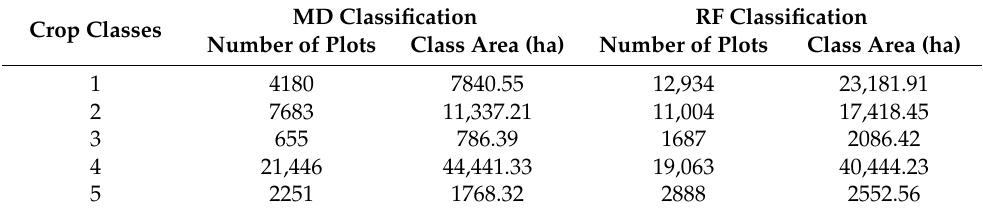
Table 9. Test separability of ROI with Jeffries-Matusita test (JM).